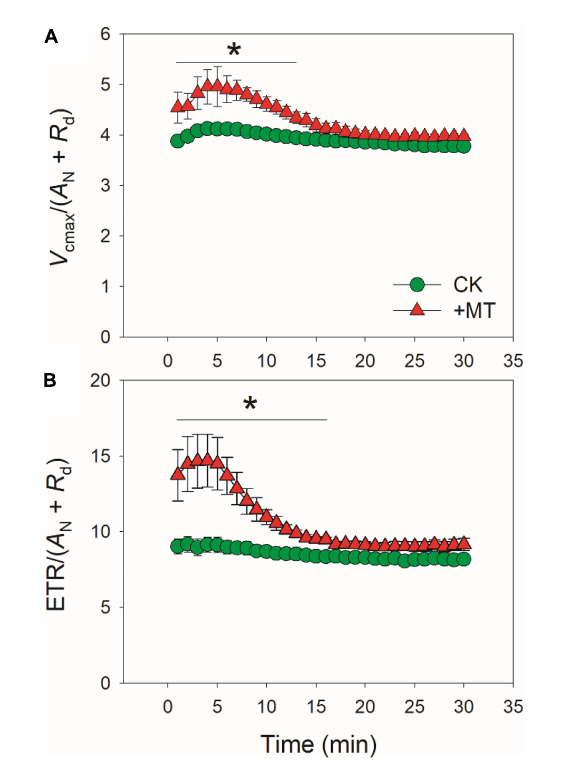
FIGURE5 Effects of exogenous melatonin (MT, 100 µ M) on the induction response of the values of Vcmax/(AN + Rd) (A) and ETR/(AN + Rd) (B) after transition from 50 to 1500 µ mol photons m − 2 s − 1 . Values are means ± SE ( n = 5). Asterisk indicates a significant difference between CK and MT-treated